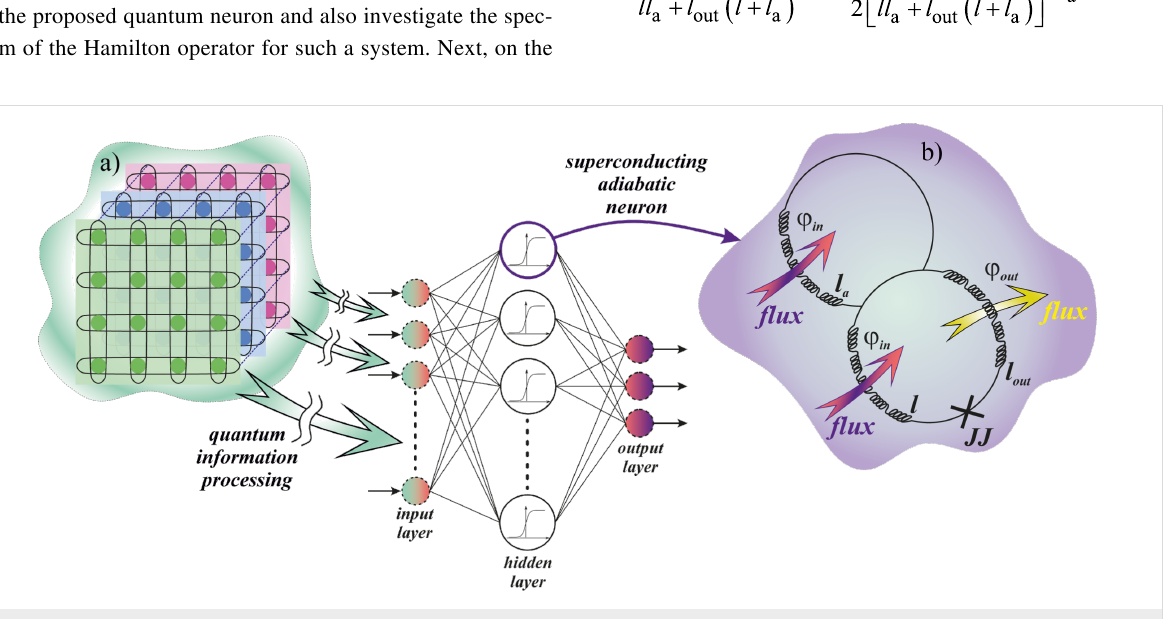
Figure 1a. Superconductor technology is a promising